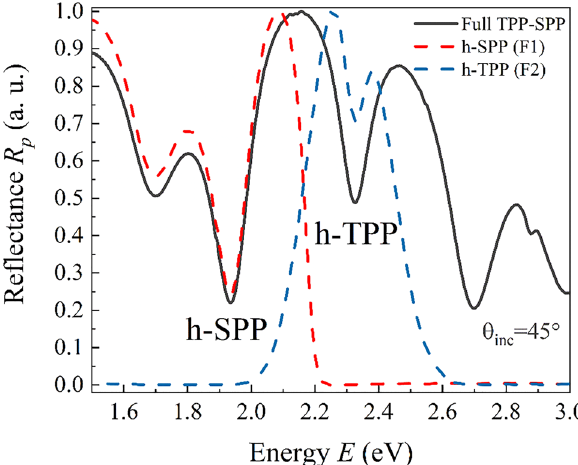
Figure 2: The experimental p -polarization re fl ectance spectra (at 45 ° AOI) of a hybrid TPP-SPP mode (gray curve) and the spectra measuredwith fi lters F1 (red curve) and F2 (blue curve) which cutout the h-SPP and h-TPP parts,